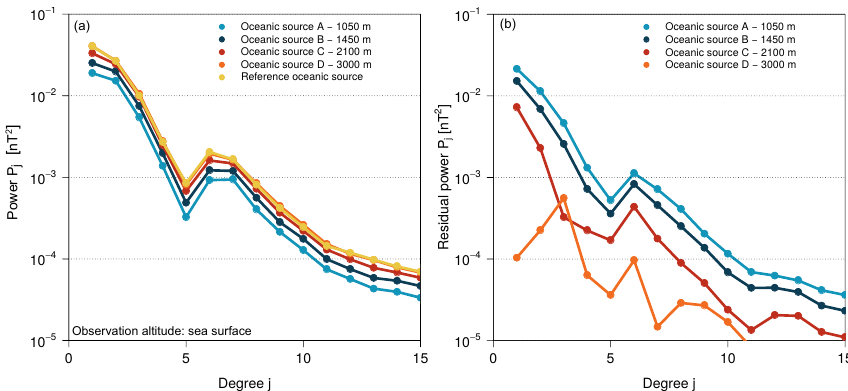
Figure 6. (a) Power spectra of the annual mean ocean-induced magnetic fields at sea surface. (b) Absolute differences between the power spectra of the scenario-wise ocean-induced magnetic fields and the reference.